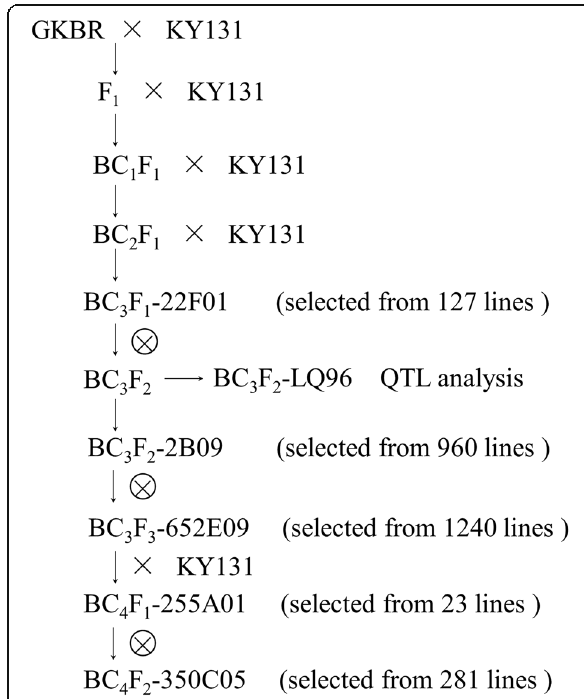
Fig. 7 Procedure for the genome reconstruction of